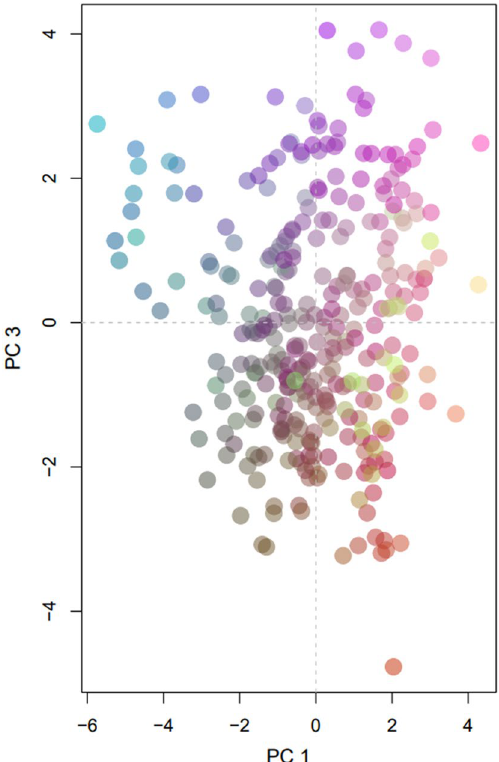
Figure 4. Principal coordinate analysis (PCoA) of bullfrog populations in Brazil used to visualize genetic differentiation among specimens from different sampling locations. Color gradient represents genetic variation among samples across PCs. Similar colors represent similar genetic structure.